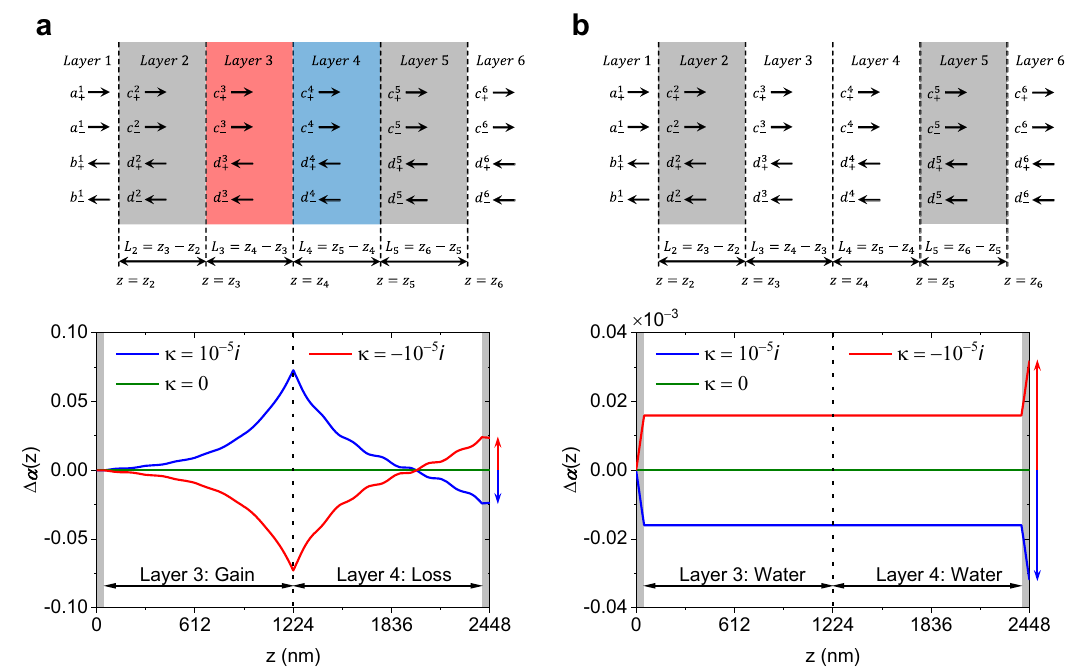
h i h i ; d j and c j beams. The pro fi le of Δ α ( z ) as a (cid:2) þ (cid:2)